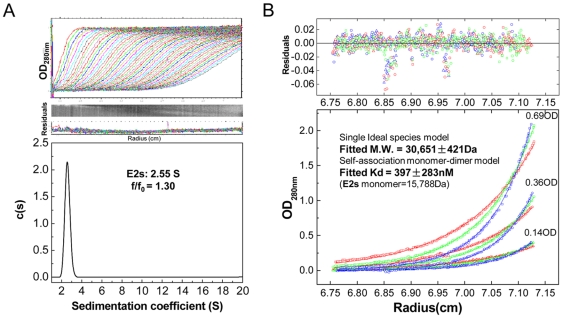
Dimerization of E2s in solution was investigated by analytical ultracentrifugation (AUC).
(A) Sedimentation velocity experiment shows that E2s behaves as a single globular species having the sedimentation coefficient of 2.55S and a hydrated friction ratio of 1.30. (B) Sedimentation equilibrium experiment indicates that E2s mainly exists as a dimer with M.W. 30,651±421 Da. The dissociation constant of the E2s dimer, Kd was fitted as 397±283 nM using the self-association model.